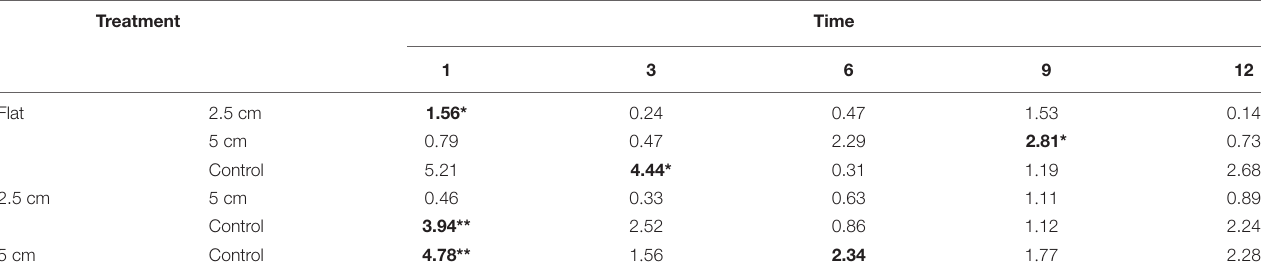
TABLE 6 | Results of Tukey pairwise comparison testing the effects of physical complexity on the recruited sessile assemblage at each time point with the number of live seeded bivalves as covariates. Treatment Time